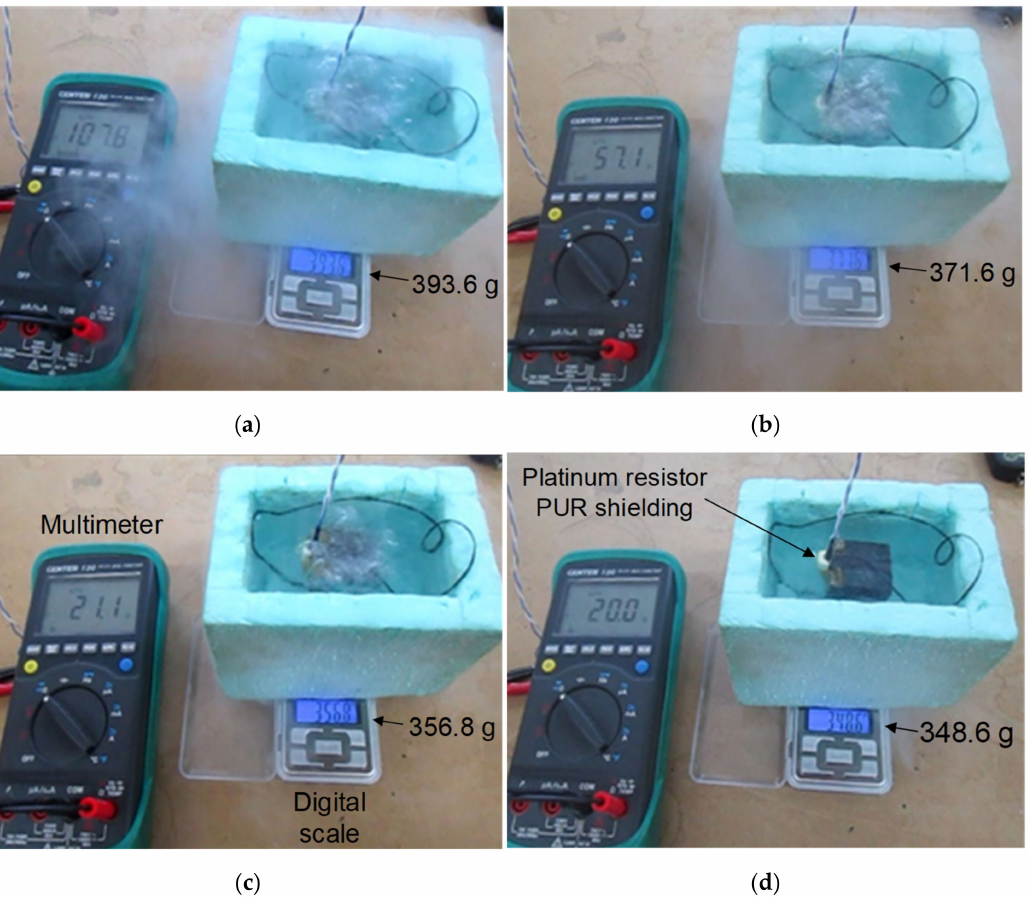
Figure 4. Measurements of the total weight and platinum resistance at the instants: ( a ) 0.5 s, ( b ) 15 s,